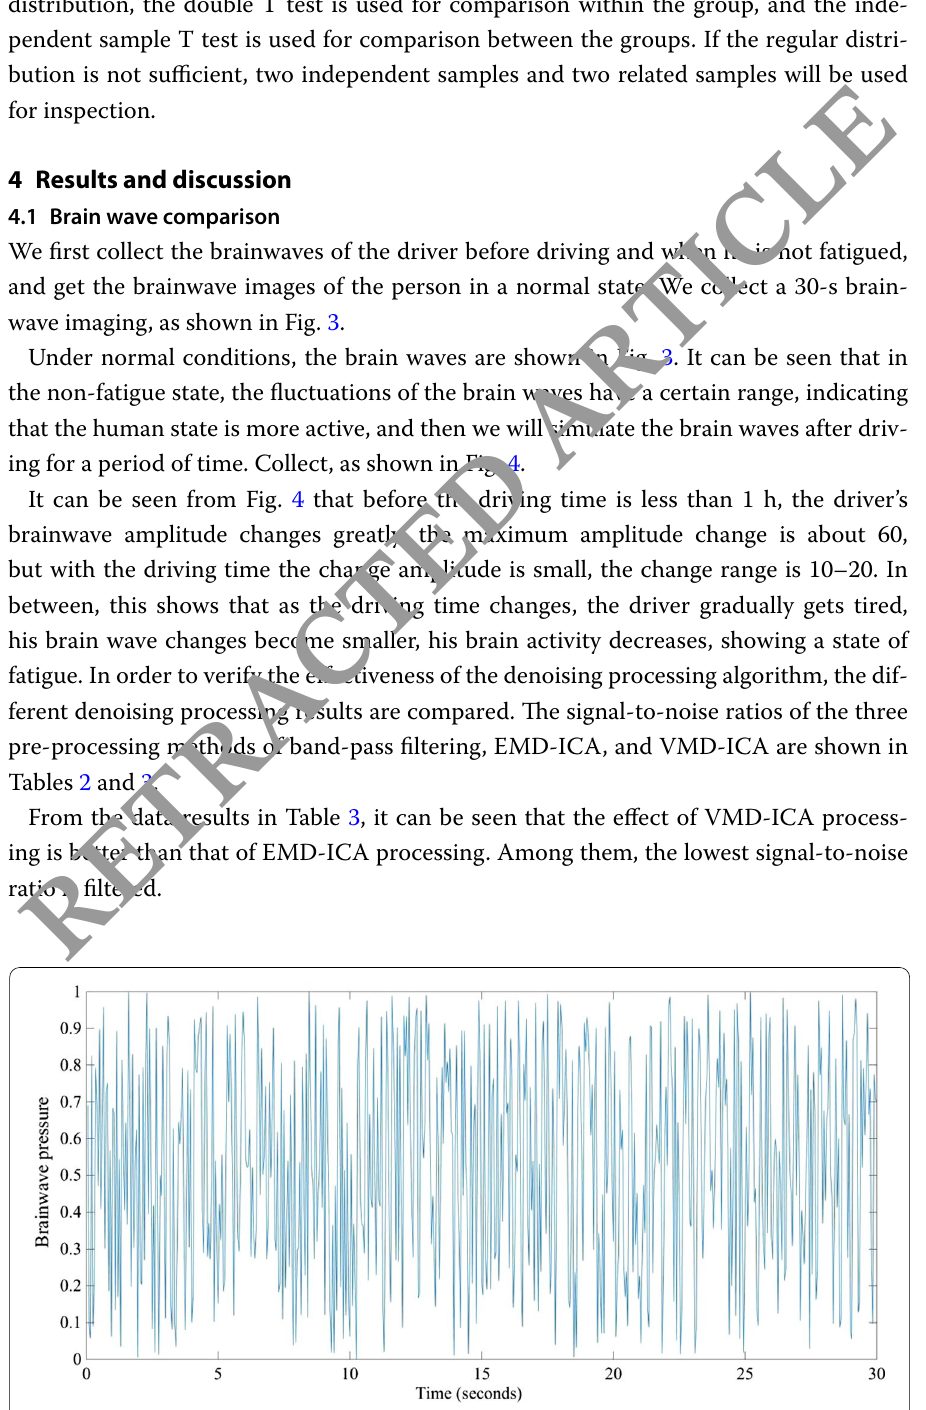
Fig. 3 Brainwave